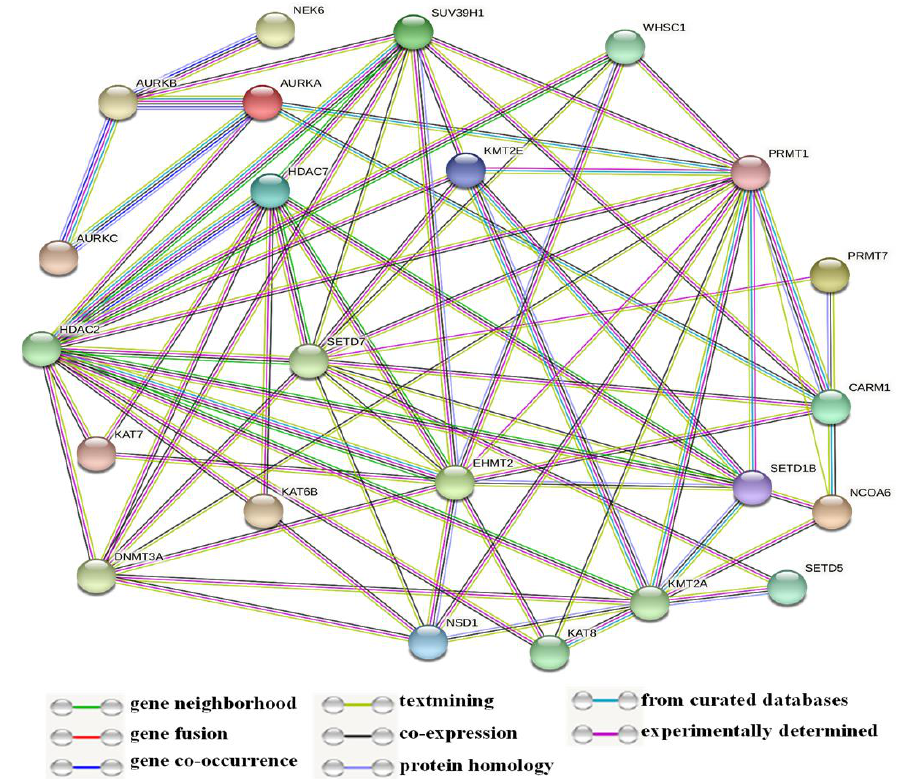
Figure 3. Illustration of network analysis of the protein associations. In this network, most of the genes are related to chromatin epigenetic modification enzymes.